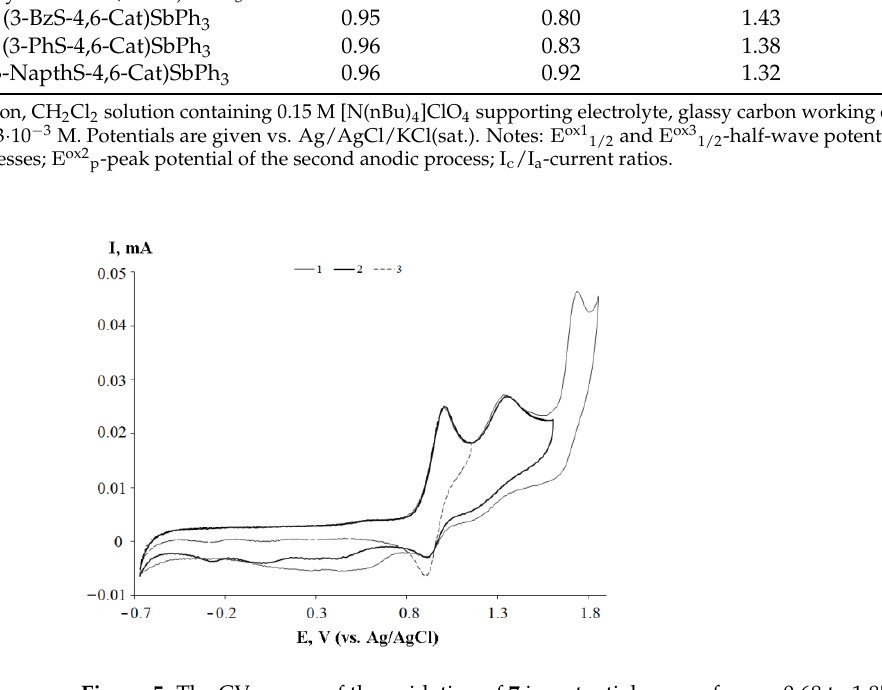
Figure 5. The CV curves of the oxidation of 7 in potential ranges from − 0.68 to 1.85 V (curve 1); from − 0.68 to 1.60 V (curve 2); from − 0.68 to 1.15 В (curve 3); (CH 2 Cl 2 , GC anode, Ag/AgCl/KCl(sat.),